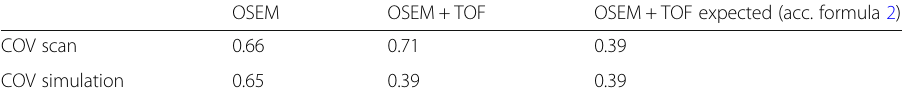
Table 2 The differences between observed and expected improvements with the use of TOF in image quality for the physical phantom data and the simulations OSEM OSEM + TOF OSEM + TOF expected (acc. formula